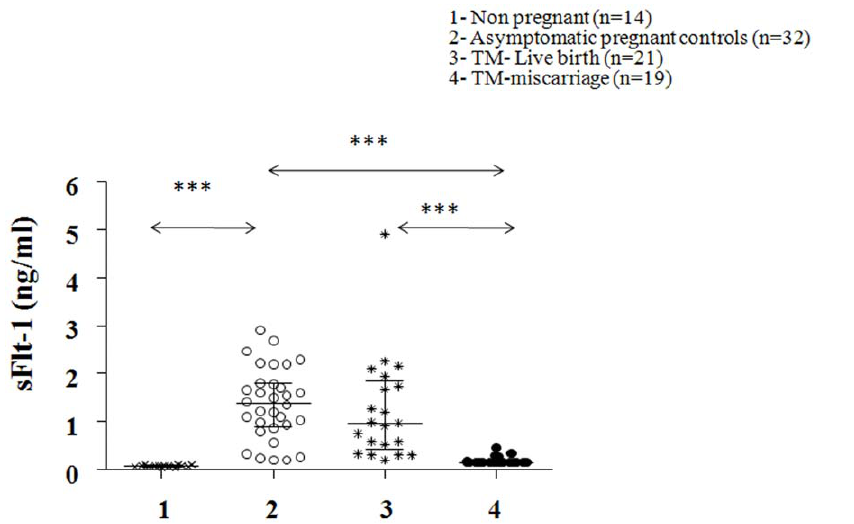
Figure 1. Scatter plot of circulating levels of serum soluble VEGF receptor 1 (sFLT-1) in the different groups of women with median and interquartile range. Group 1 (non-pregnant women, n=14), group 2 (normal pregnant women, n=32), group 3 (threatened miscarriage patients with a live birth outcome, n=21) and group 4 (threatened miscarriage patients with a subsequent miscarriage, n=19). General linear analysis of variance was carried out to study the statistical significance between the groups with posthoc tests. P , 0.001=***.